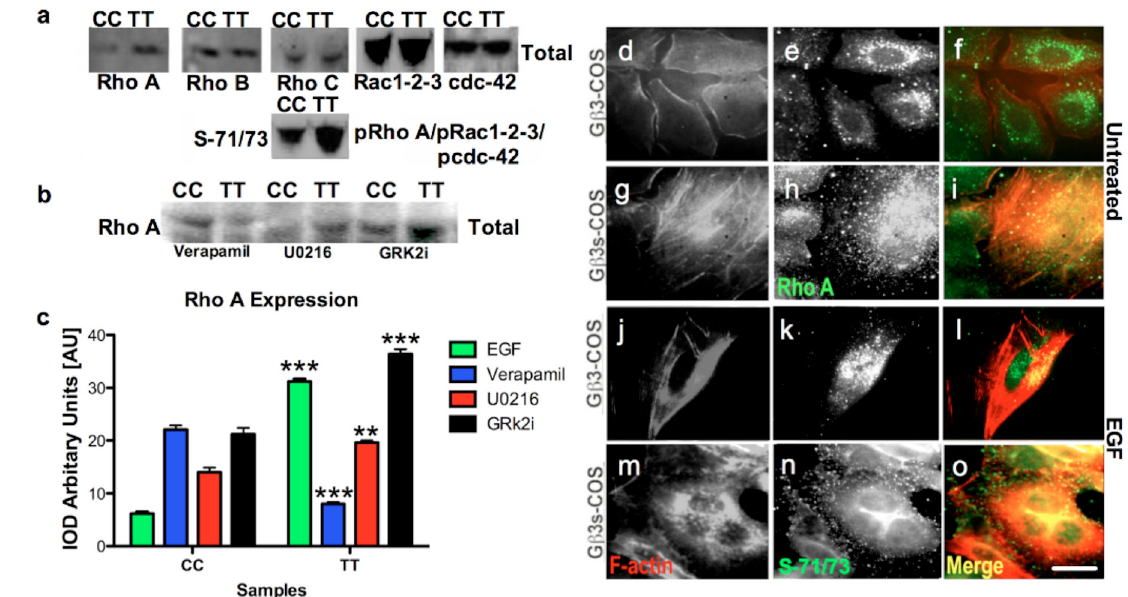
Figure 14. Contribution of RhoA in Gβ3s subunit specific cell migration phenotype. Immuno reactivity of total RhoA, RhoB, RhoC, Rac 1-2-3 and CDC42 and phospho immuno reactivity of Rho A at S-73 and Rac 1-2-3, cdc42 at S-71 upon EGF stimulation were determined by western blotting. TT lymphoblast lysates showed enhanced total RhoA expression and RhoA/Rac 1-2-3/cdc-42 activity when compared to normal CC (a). Rho A expression was analysed in CC and TT lymphoblast cell lysates upon stimulation with EGF in the presence of inhibitors (b). Data presented in all panels are the mean with standard error (bars) of n = 3 independent experiments. Statistical significance is shown as *P<0.05, **P<0.01, ***P<0.001. G b 3s-COS cells showed enhanced co-localisation of RhoA (g-i) and phosphorylated RhoA, Rac 1-2-3 and CDC42 (m-o) with actin stress fibers. The images are taken from different fields of view under 40x objective with further 1.5x magnification. Bar = 13 m